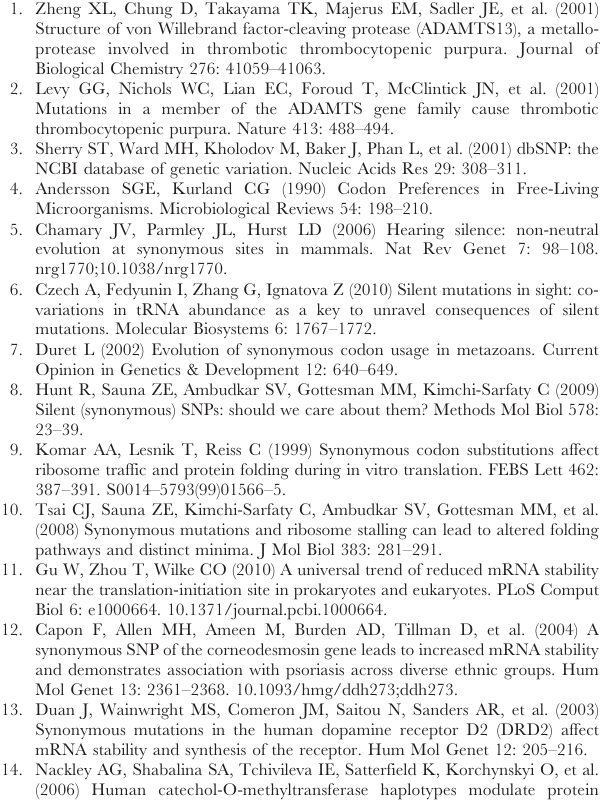
Table S2 Summary of in vitro data for synonymous and nonsynonymous